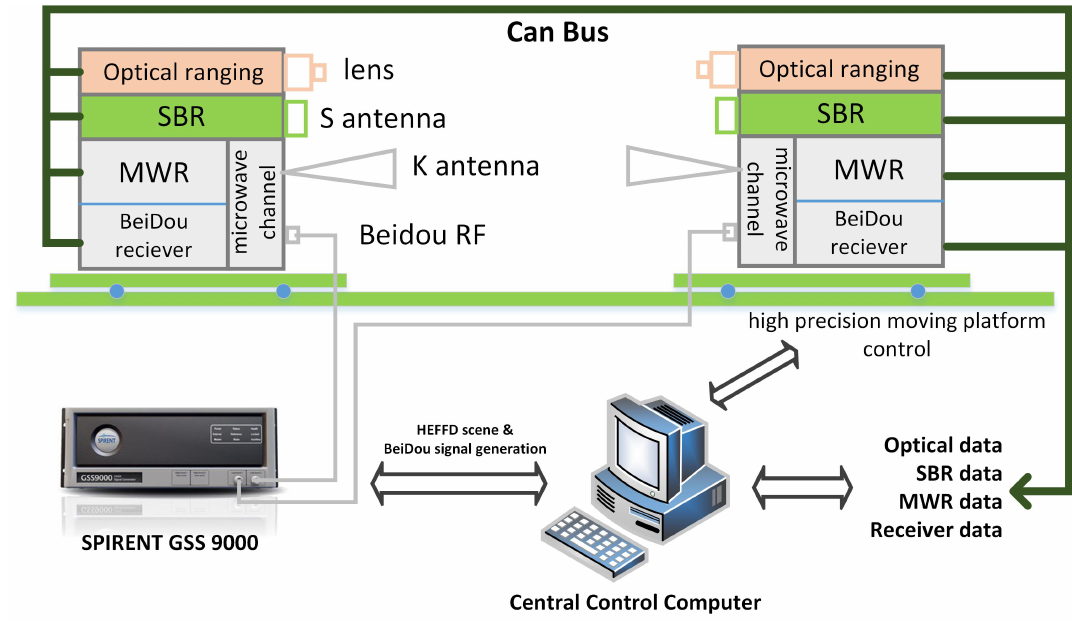
Figure 10. Block diagram of the simulation platform, mainly including a high-precision 6-DOF moving platform, optical/S-band ranging (SBR)/MWR/BeiDou payloads, a SPIRENT GSS9000 simulator, central control computer, and standard CAN